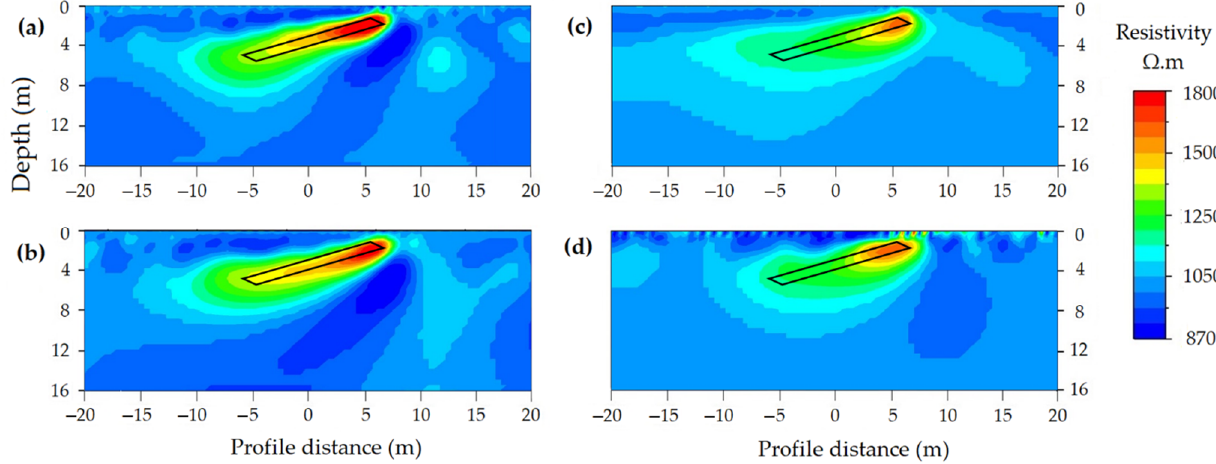
Figure 16. The inverted resistivity model for the inclined (45°) cavity using: ( a ) DD array, ( b ) PD array, ( c ) WS array, ( d ) PP array. The box indicates the actual cavity target.